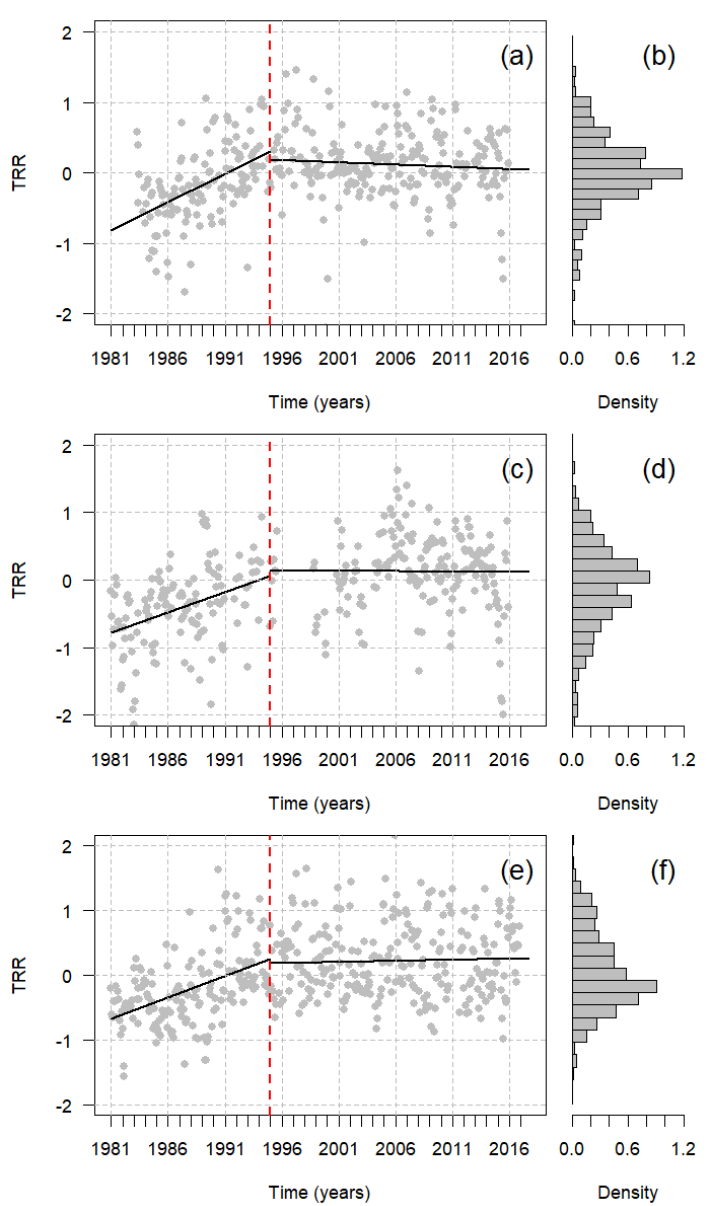
Figure 5. ( a ) Transformation of Relative Residuals ( TRR , gray points), linear regression of TRR (black line) and histogram of TRR (bars) for C1 ( a,b ), C2 ( c,d ) , and C3 ( e,f